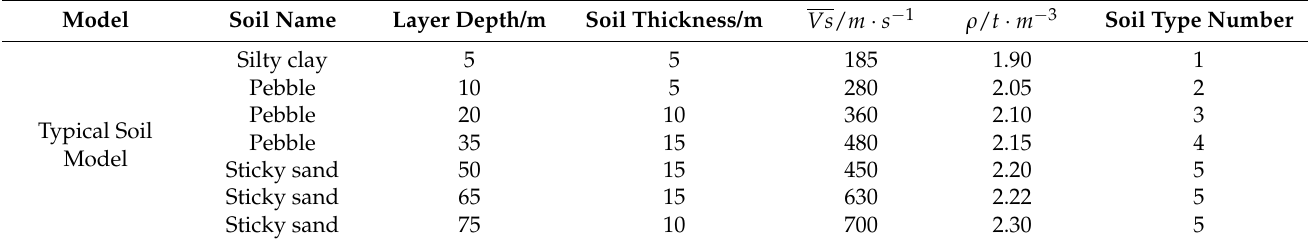
Table 5. Typical soil models and soil mechanical parameters.